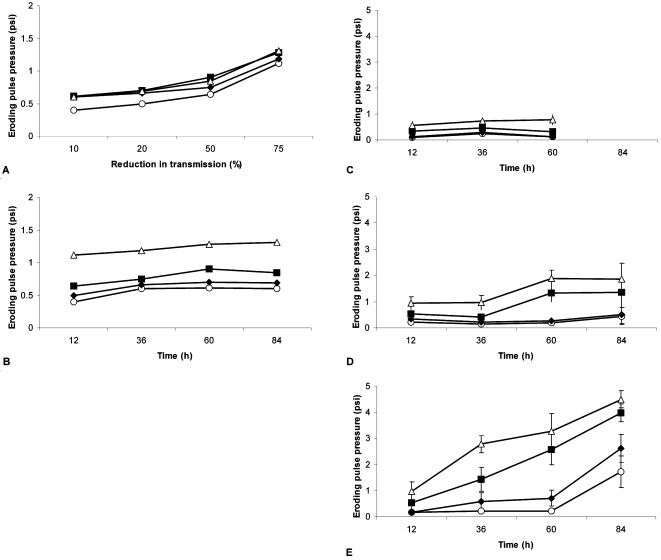
Erosion profiles from stromatolite material and controls measured during the winter.A. The mean pressure required to cause sequentially increasing levels of erosion in controls. Erosion thresholds (10, 20, 50 and 75% reduction in transmission against clear water [100%], respectively) were recorded for replicate incubations with increasing incubation time (o = 12 h, ♦ = 36 h, ▪ = 60 h and Δ = 84 h). B. Comparison of the mean pressure required to cause a specific level of erosion in control systems (o = 10%, ♦ = 20%, ▪ = 50% and Δ = 75%) with time. C–D. Comparison of the mean pressure required to cause a specific level of erosion for winter series (particle resuspension causing a reduction in transmission, o = 10%, ♦ = 20%, ▪ = 50% and Δ = 75%) against period of incubation for each of the experimental sites. C. Site 1. D. Site 5 and E. Site 10. (n = 7 for all treatments).